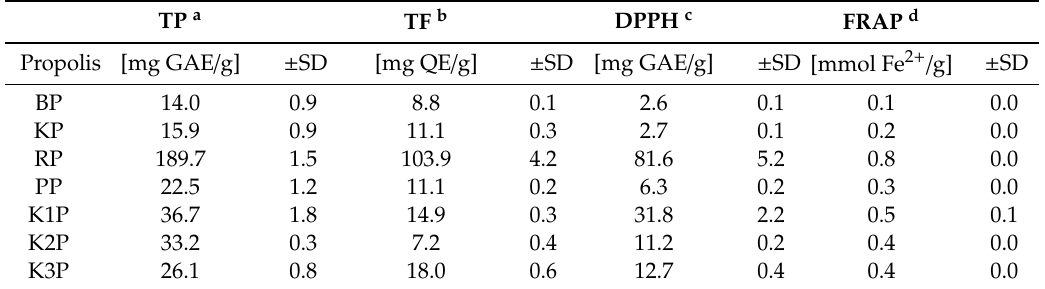
Table 5. Total phenol, flavonoid content and antioxidant properties of the propolis